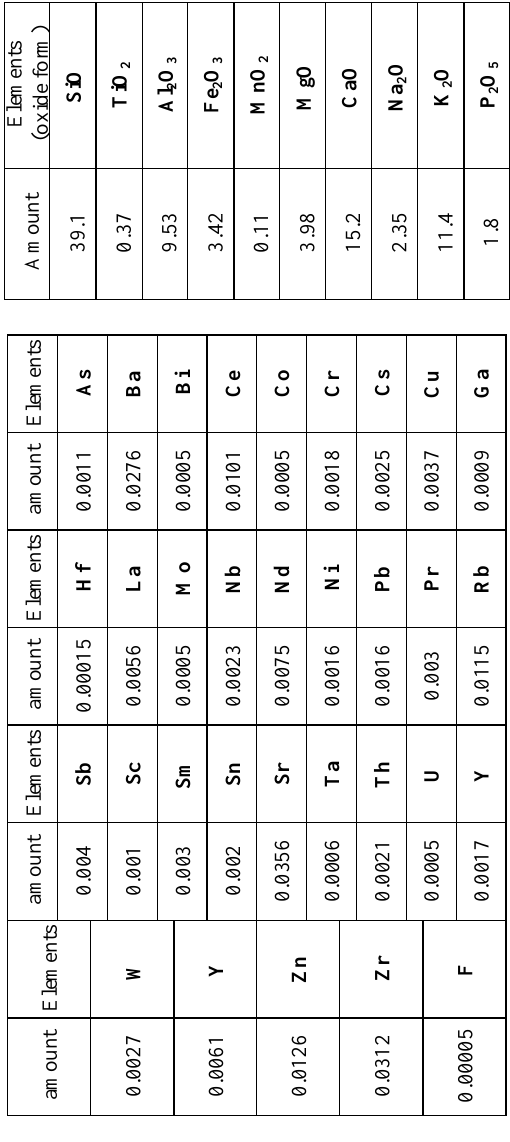
Table 3. Amount of mineral elements in ash of natural mumijo